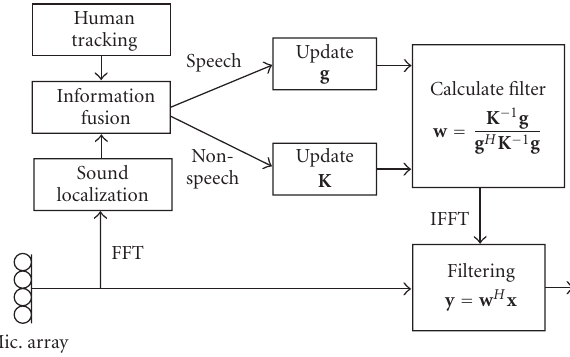
Figure 8: Block diagram of the ML